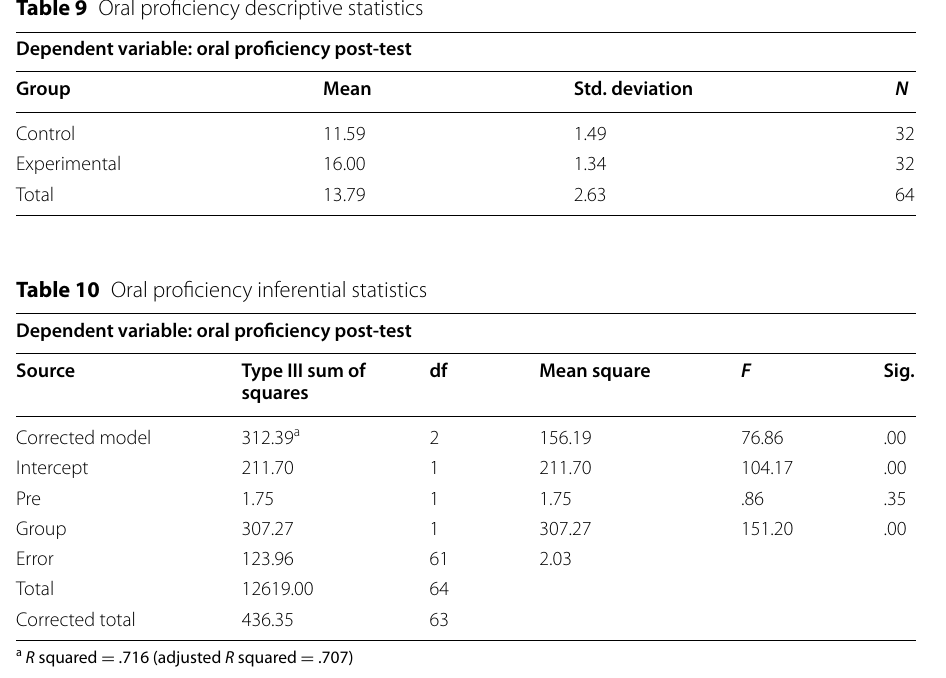
.716 (adjusted R squared =